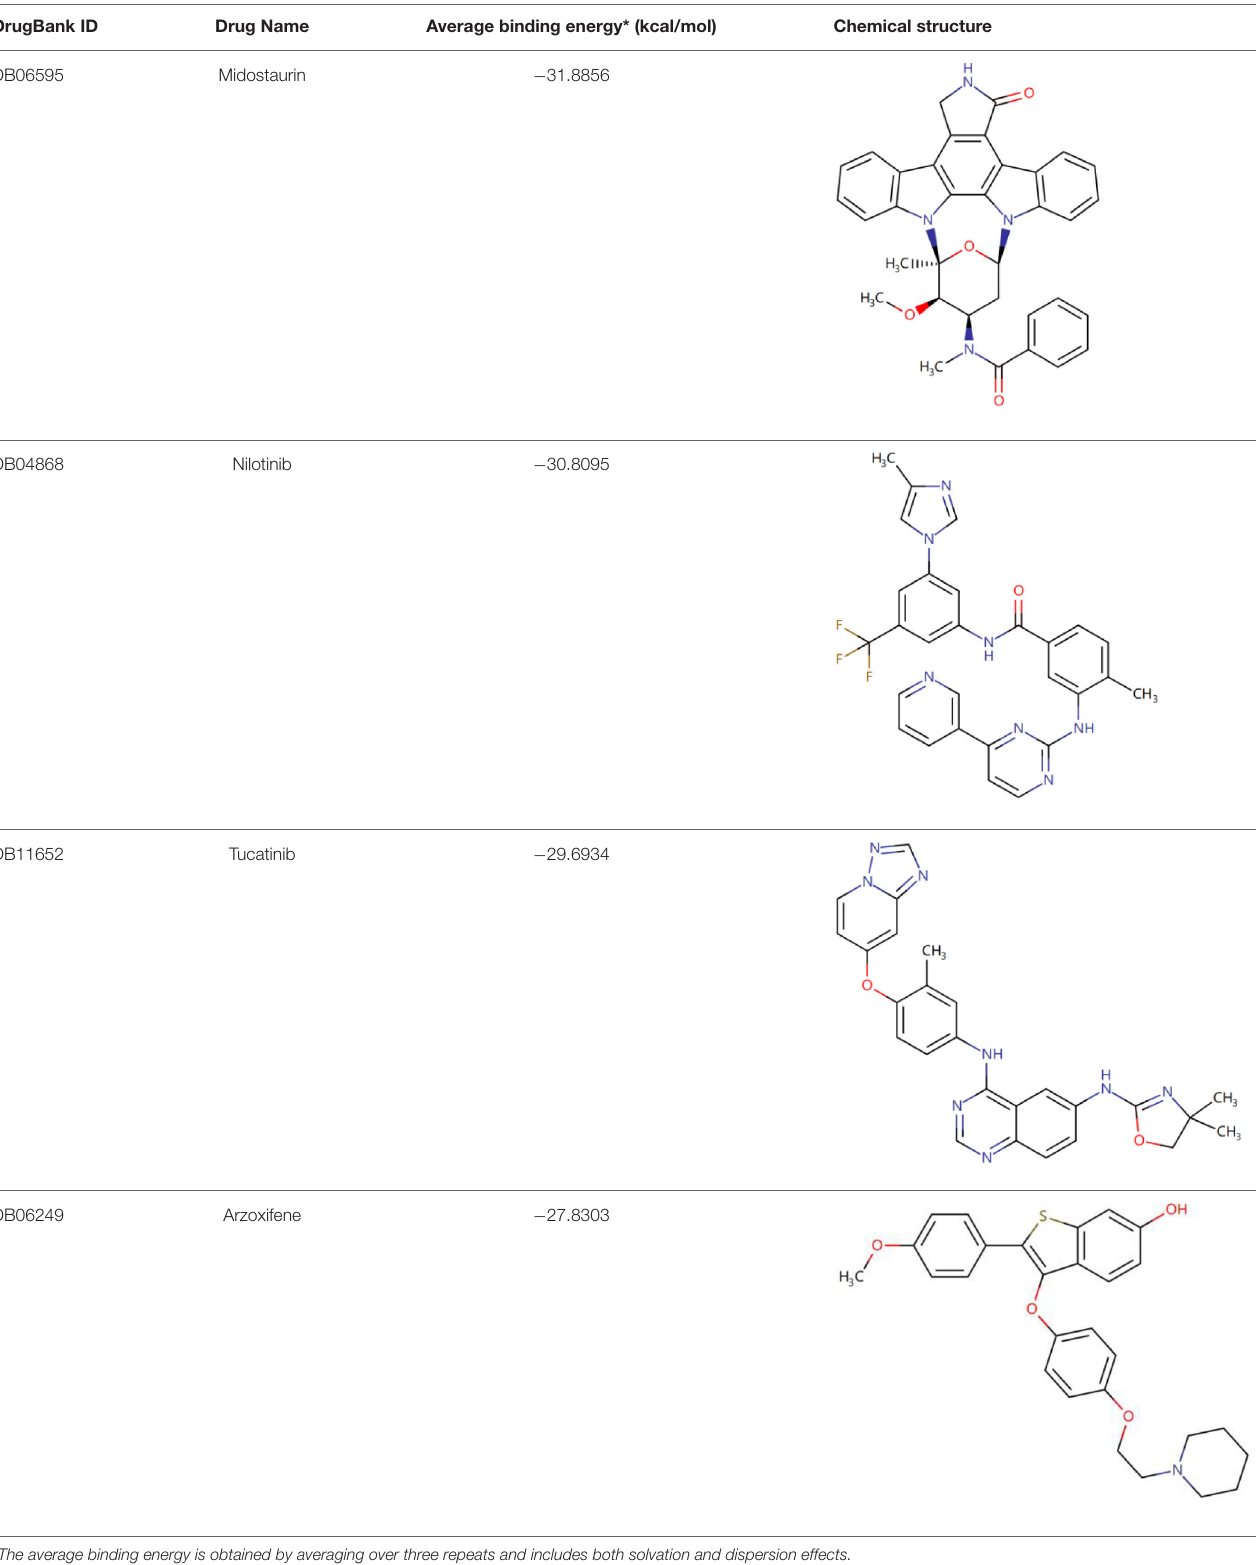
TABLE 2 | Four predicted anticancer drugs for the potential GDDS